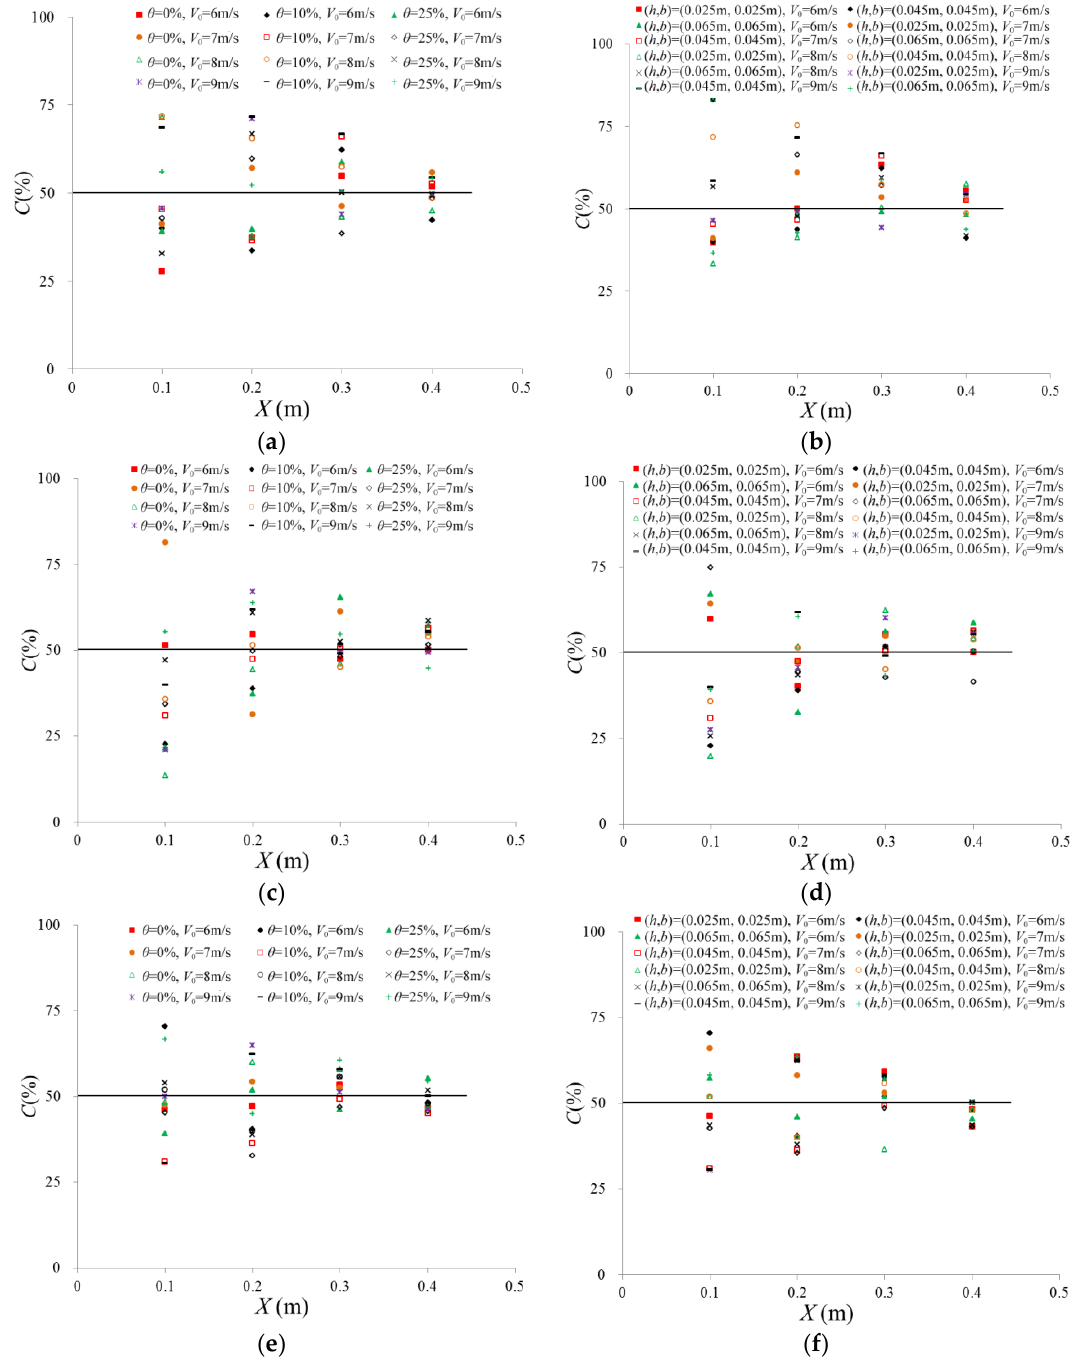
Figure 9. Air concentration corresponding to the maximum air bubble frequency. Upper nappe ( a ) ( h , b ) = (4.5 cm, 4.5 cm). ( b ) θ = 10%; lower nappe ( c ) ( h , b ) = (4.5 cm, 4.5 cm). ( d ) θ = 10%; side nappe ( e ) ( h , b ) = (4.5 cm, 4.5 cm). ( f ) θ = 10%. The relative location corresponding to the maximum air bubble frequency is shown in Figure 10.